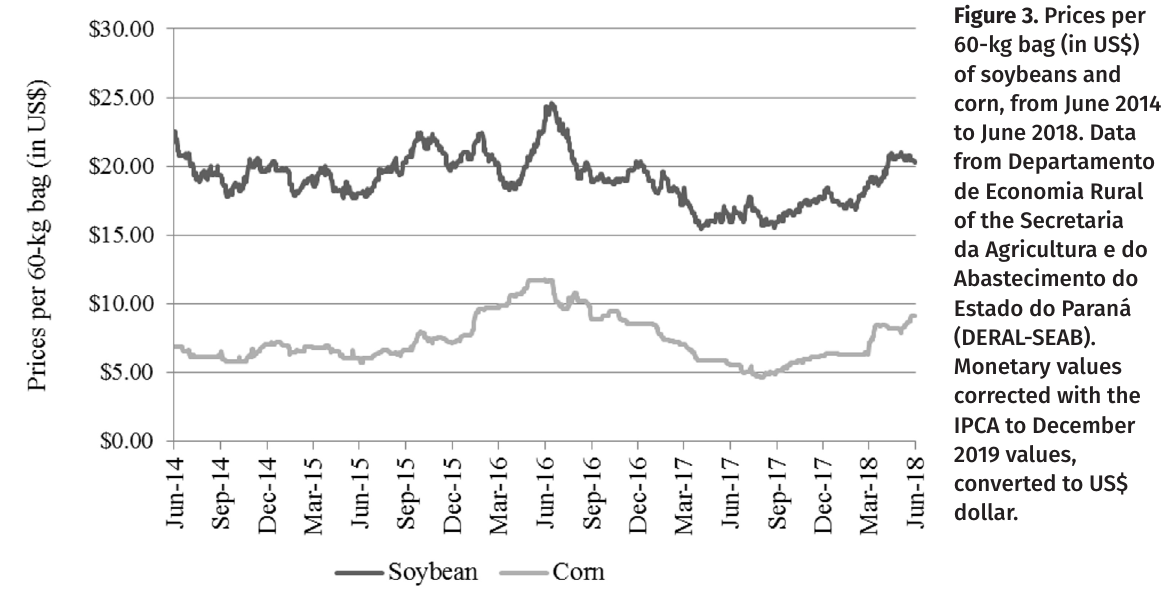
Figure 3. Prices per 60-kg bag (in US$) of soybeans and corn, from June